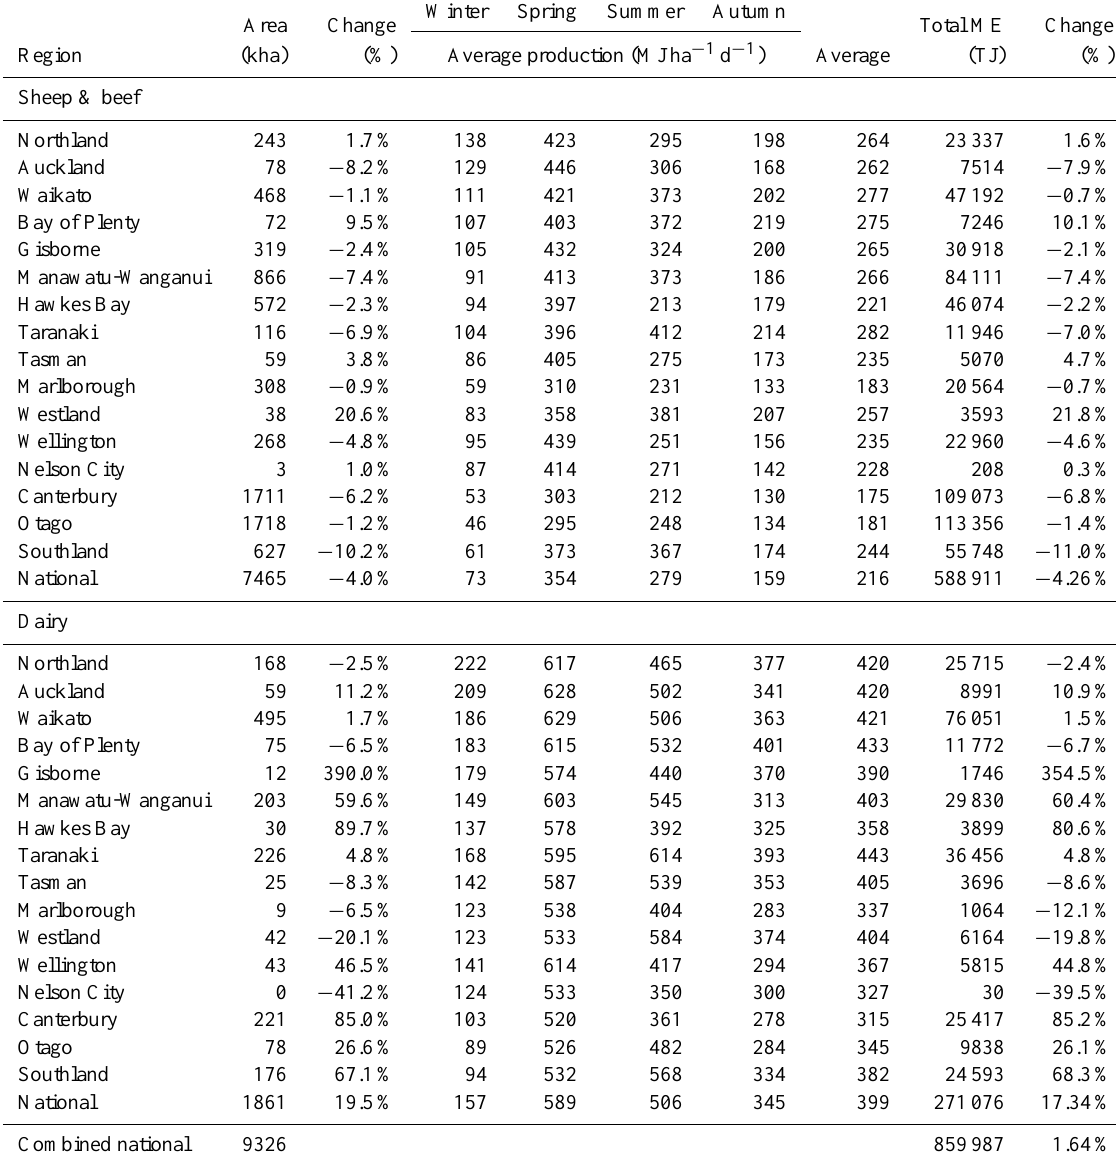
Total ME Change